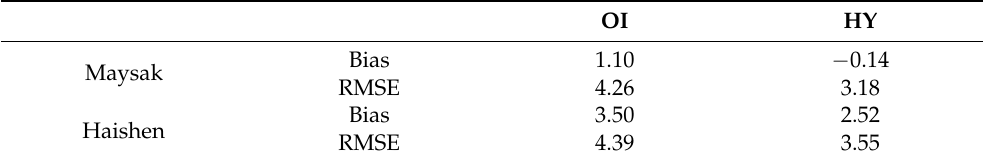
Table 3. Comparison of simulated maximum wind speed at 10 m (MWS) during the typhoon landfall period for the top 10% of the observation in the OI and HY